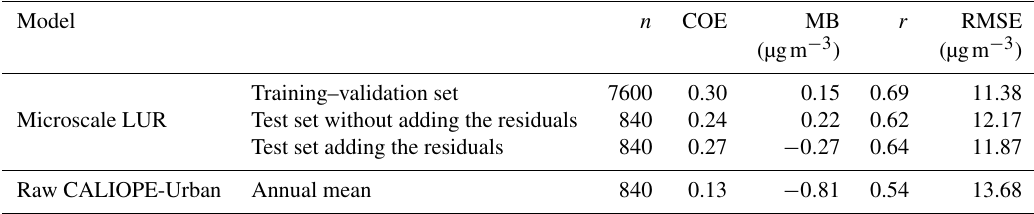
Table 2. Statistical results of the microscale LUR model in nested CV. The 2017 annual mean concentration of NO 2 of the raw dispersion model (CALIOPE-Urban) is also shown. The parameter n stands for the number of data points used to compute the